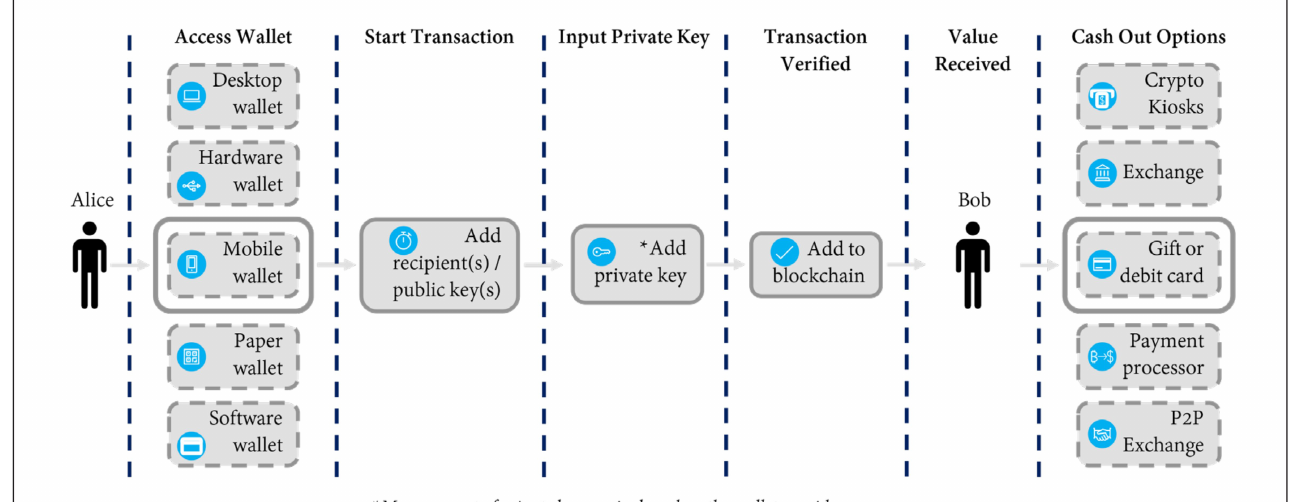
Figure 1. Figure of anatomy of cryptocurrency transactions taken from